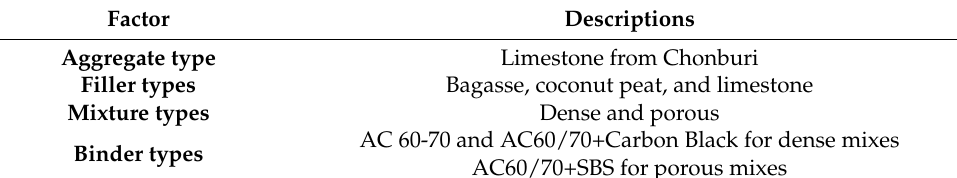
Figure 1. Aggregate gradation. Table 1. Summary of factors to determine aggregate packing of permeability samples.